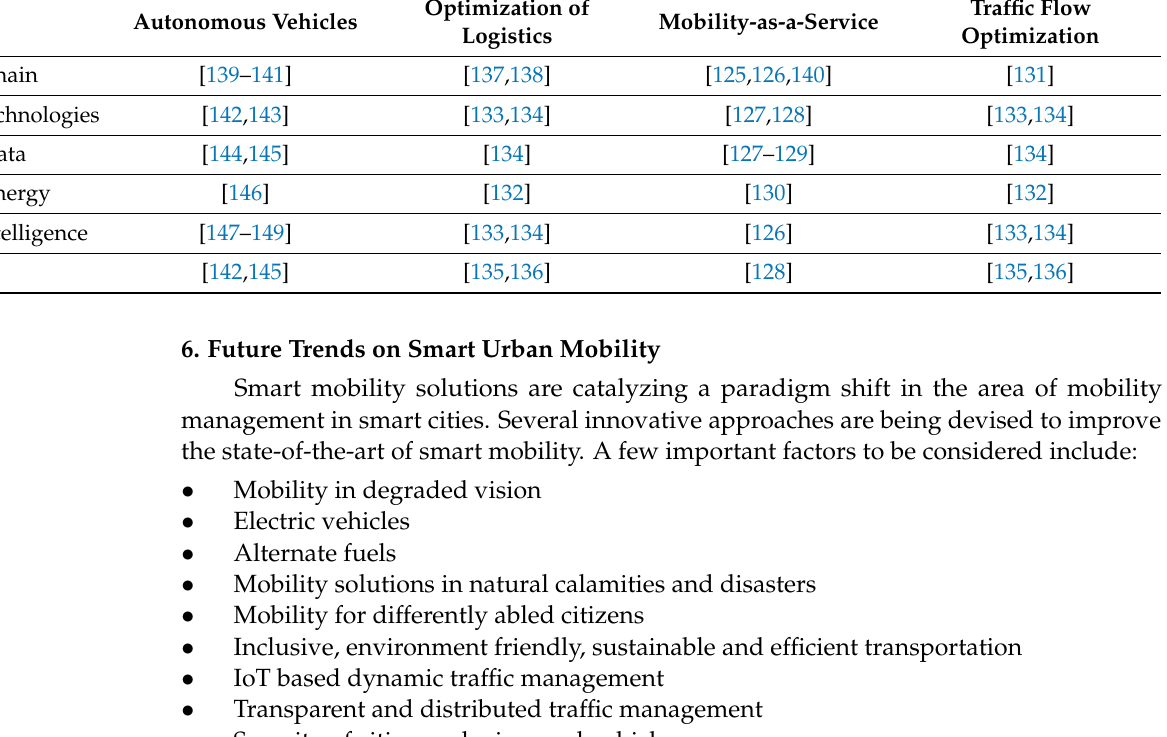
Table 7. Summary of studies that apply enabling technologies to main services and application of smart mobility. Optimization of Traffic Autonomous Vehicles Mobility-as-a-Service Logistics